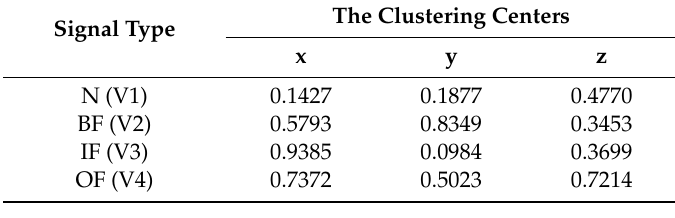
Table 3. The clustering centers of the four types of signals.